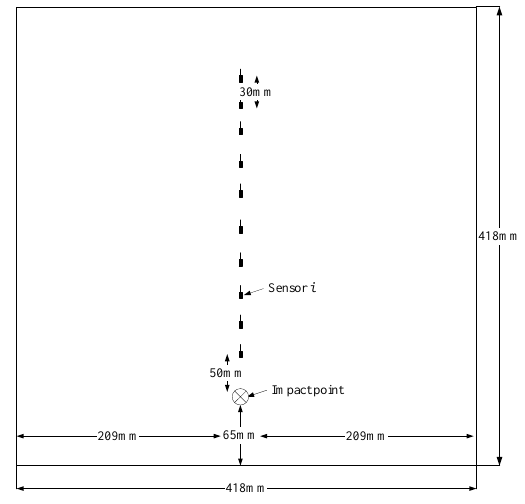
Figure 2: Sample plate size and strain gauges